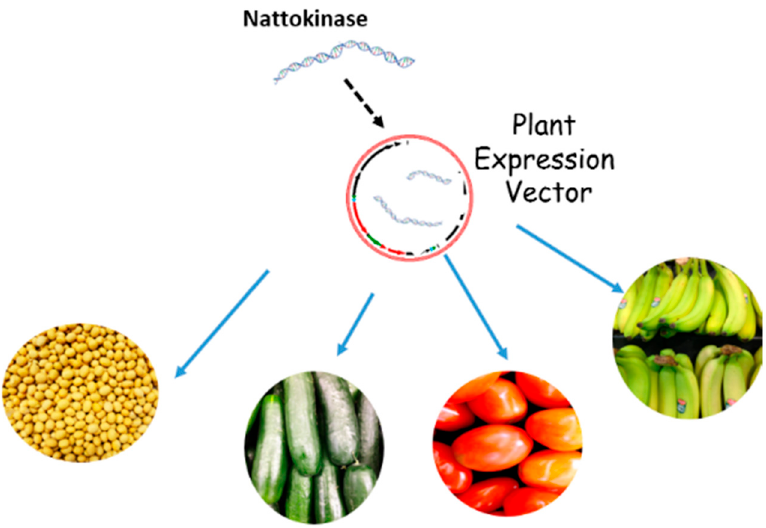
Figure 7. Plants as potential factories for NK production.